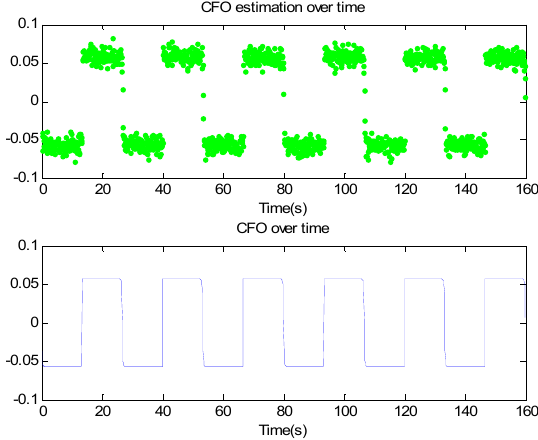
Figure 6. CFO estimation over time with a constant velocity (v = 75 m/s) .